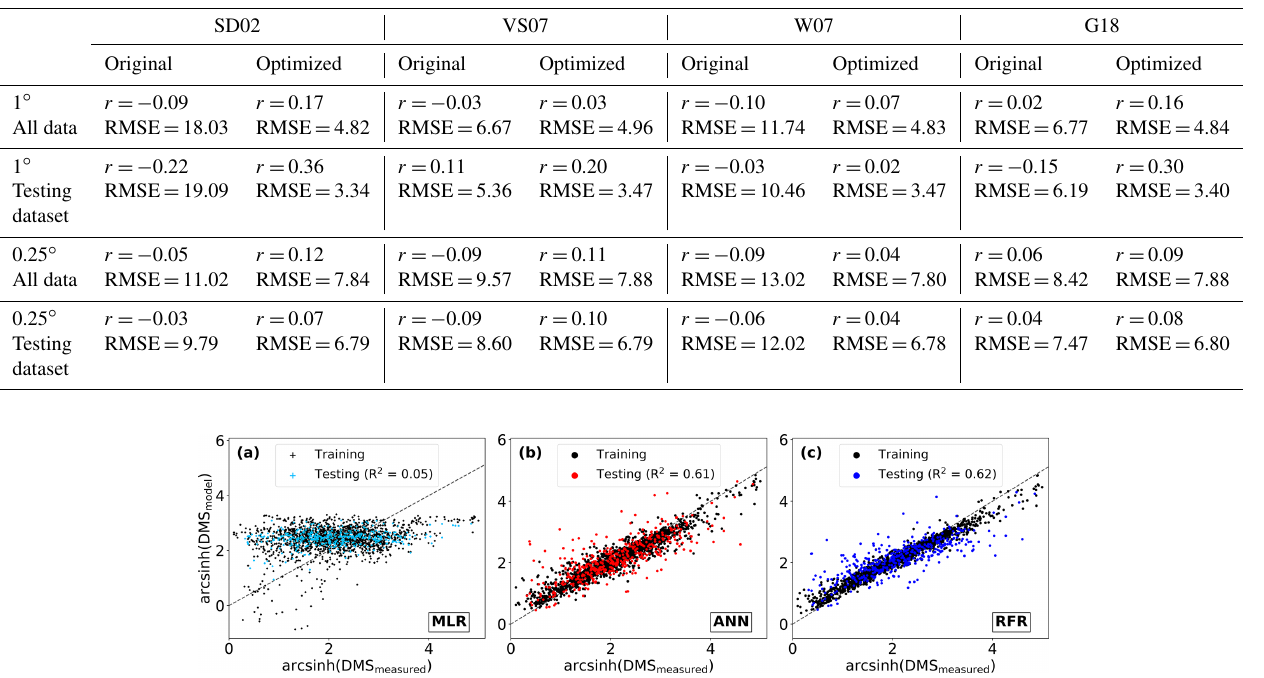
Table 2. Performance of statistical DMS algorithms on NESAP DMS observations binned to monthly 1 and 0.25 ◦ resolution. Pearson correlation coefficients ( r ) and root mean square error (RMSE, in nM) are obtained from the SD02, VS07, W07, and G18 algorithms (see Sect. 2.4) using either their original published coefficients or coefficients derived from non-linear least squares optimization. Algorithm